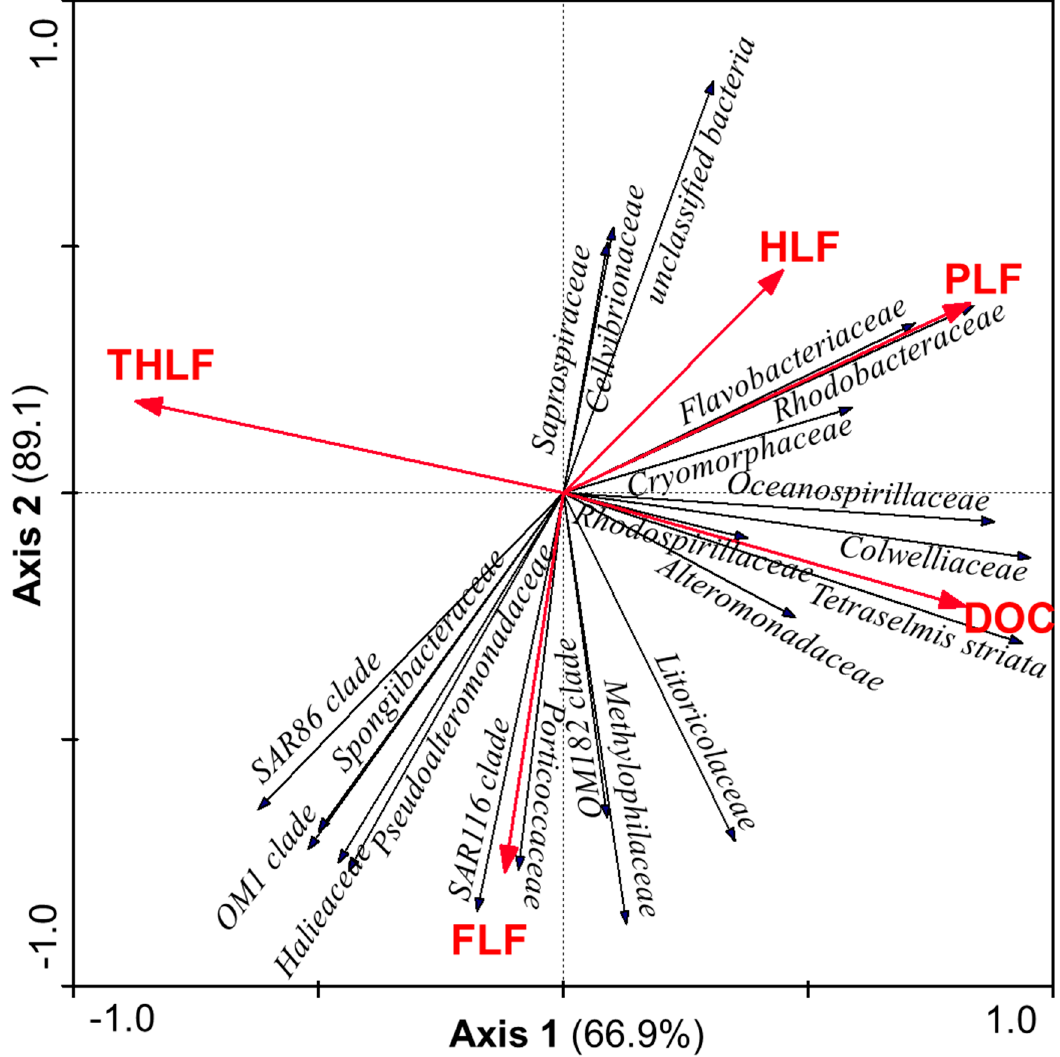
Figure 10. The redundancy analysis to determine the relationship between dissolved organic carbon (DOC) including four different fractions (PLF, protein-like fluorescence; FLF, fulvic-like fluorescence; HLF, humic-like fluorescence; THLF, terrestrial humic-like fluorescence) and bacterial groups at the family level.